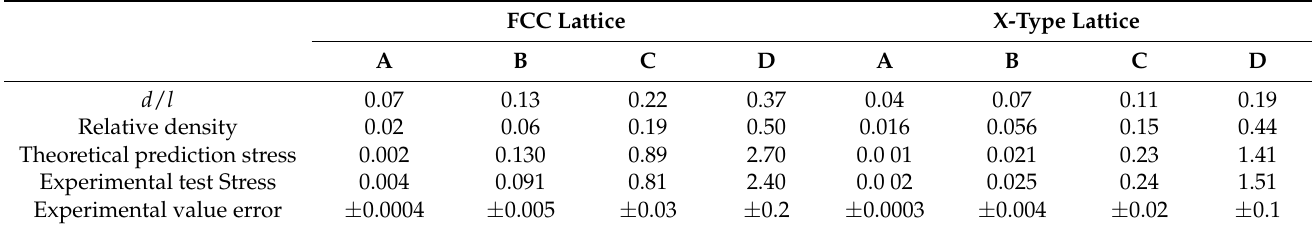
Figure 8. The analytical predictions of normalized failure stresses with experimental measurements. Table 3. Comparison of measured and predicted mechanical properties of micro-architectures.